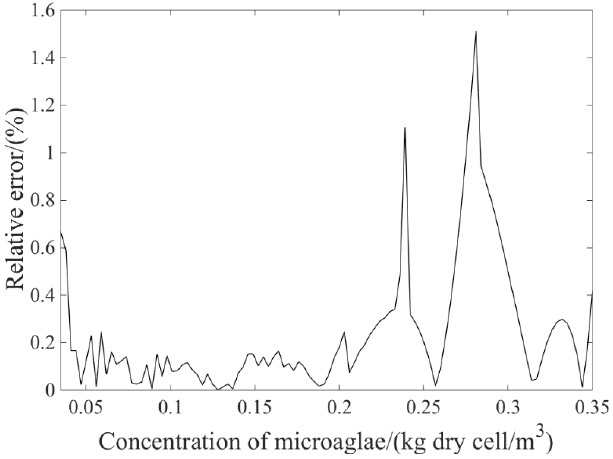
Figure A3. The spectral emissive power of blue LED light [9].